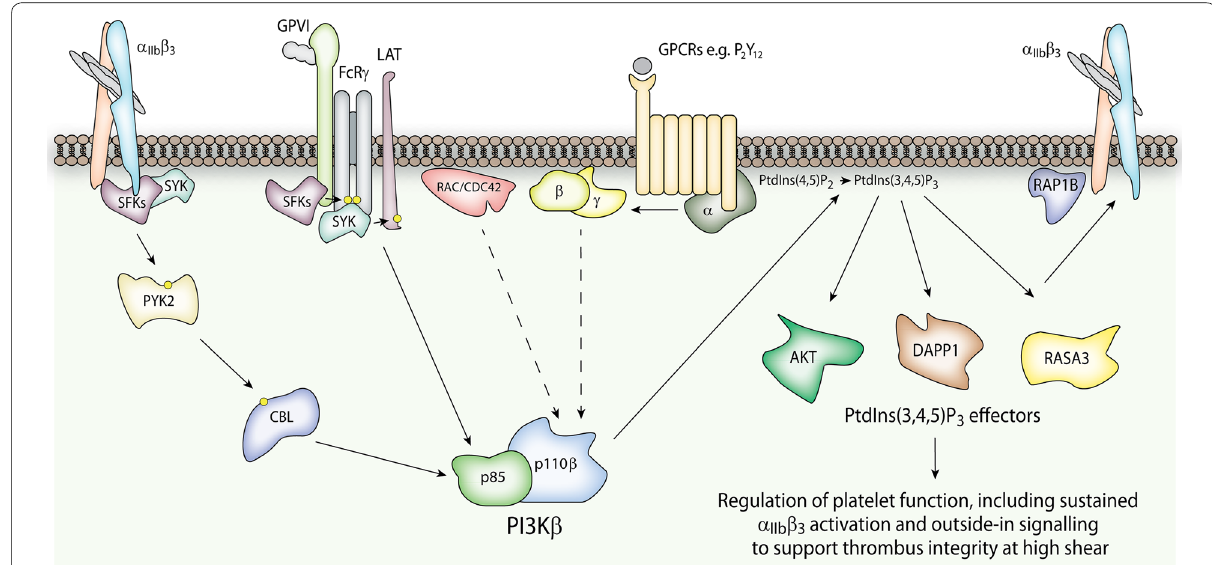
Fig. 3 The role of PI3Kβ in platelets. Class I PI3Kβ is considered a potential antithrombotic target due to its functional role downstream of various platelet receptors, and has received the most intense clinical interest of the PI3Ks so far in this setting. In particular, it plays a key role in sustaining integrin α IIb β 3 signalling to support stable thrombus formation under high shear, acting via the regulation of various cellular effectors which are responsive to its catalytic product, PtdIns(3,4,5)P 3 . PI3Kβ can receive activatory input via multiple interactions, including direct interaction of p85 with CBL downstream of α IIb β 3 , association of the SH2 domains of p85 with phosphorylated tyrosines on receptors and adaptors downstream of Glycoprotein VI (GPVI), and interactions of p110β with RAC/CDC42 and the Gβγ subunits of activated heterotrimeric G proteins downstream of GPCRs such as P 2 Y